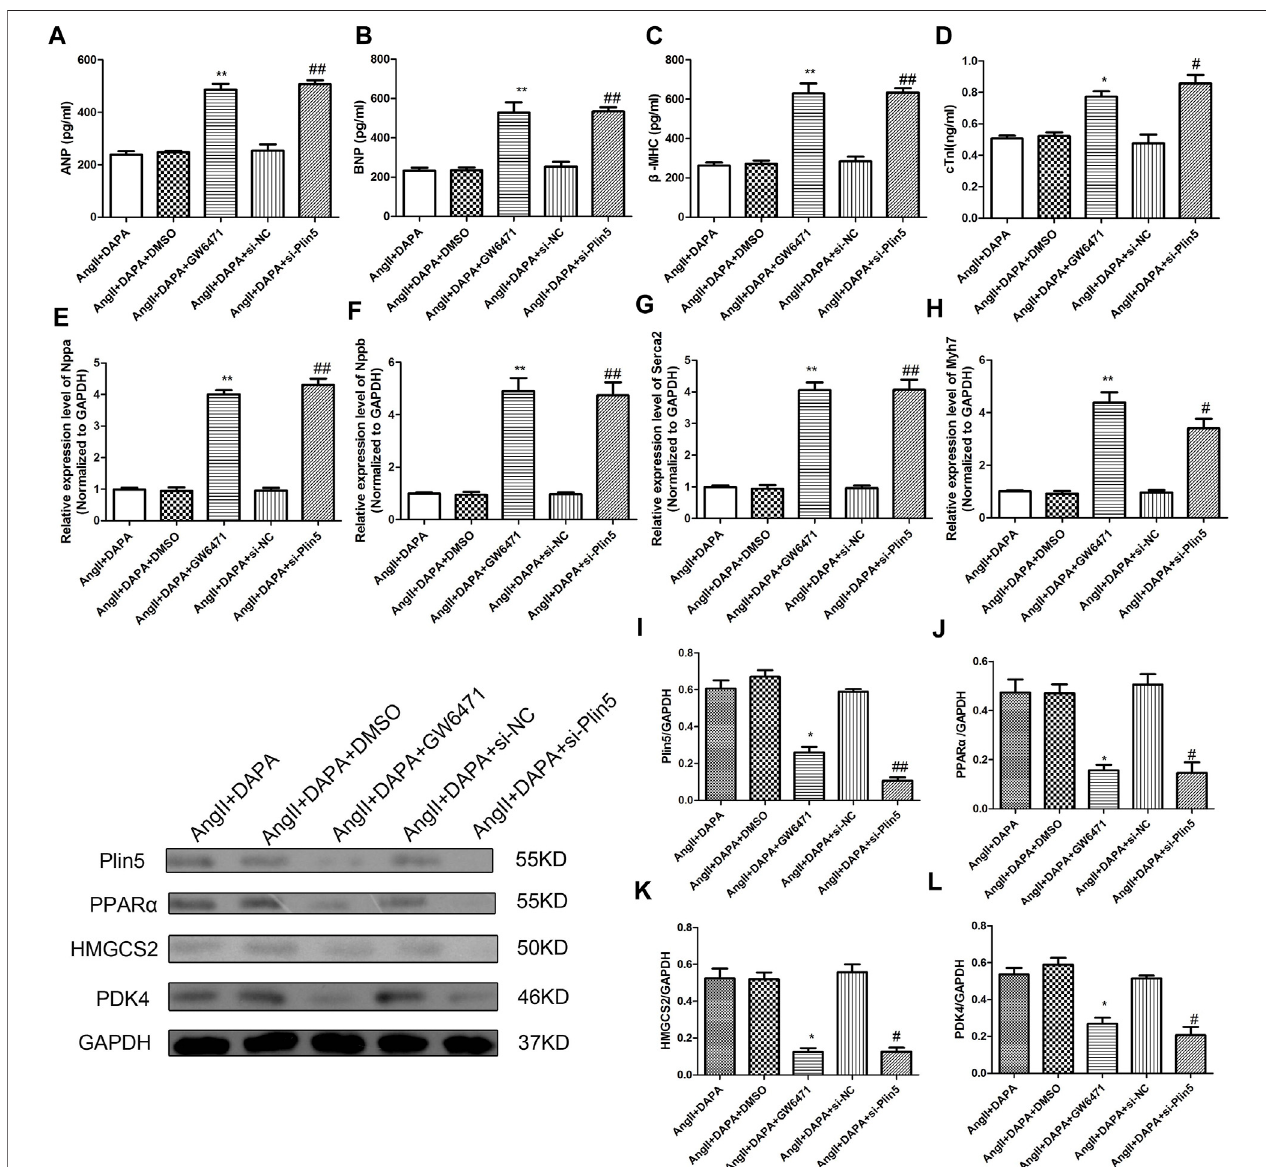
FIGURE 7 | Silence Plin5 or GW6471 could reverse the protective effect of dapagli fl ozin-mediated PPAR α signaling axis in AngII-induced cardiomyocyte hypertrophy. The content of ANP (A) , BNP (B) , β -MHC (C) and cTNI (D) in cell culture supernatant was detected by ELISA kits. qRT-PCR analysis was performed to detect the mRNA expression of Nppa (E) , Nppb (F) , Serca2 (G) and myh7 (H) in different groups. (I – L) Western blotting assay was used to detect the protein expressionsofPlin5,PPAR α ,HMGCS2andPDK4incardiomyocyteofdifferentgroups.Thedatawereexpressedasmean ± SD, n (cid:1) 3,* p < 0.05,vs.AngII+DAPA + DMSO group; # p < 0.05, vs. AngII + DAPA + si-NC group.